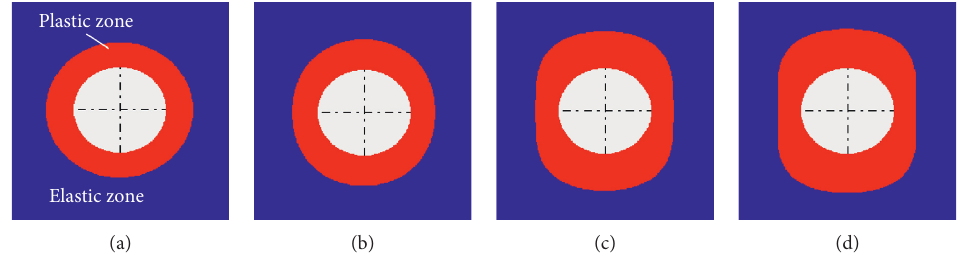
Figure 1: Evolution of the elliptical plastic area in nonuniform stress field ( a � 2.5m; C � 3 MPa; φ � 25 ° ; P (c) η � 1.4. (d) η � 1.6.